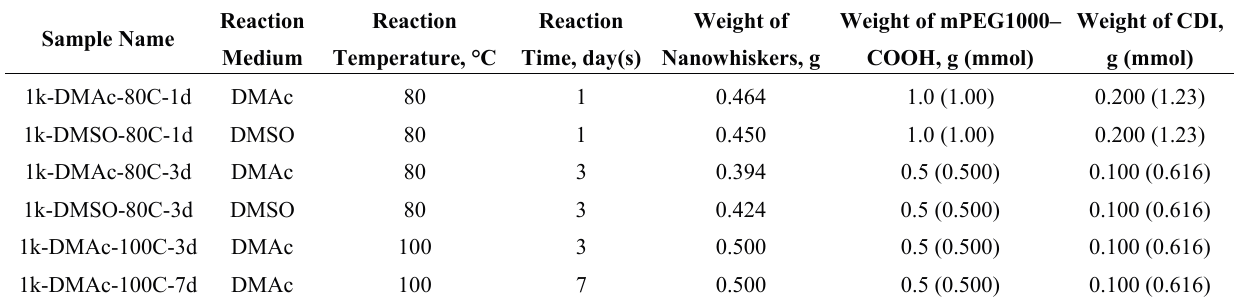
Table 3. Reaction conditions used to prepare mPEG-grafted nanowhisker